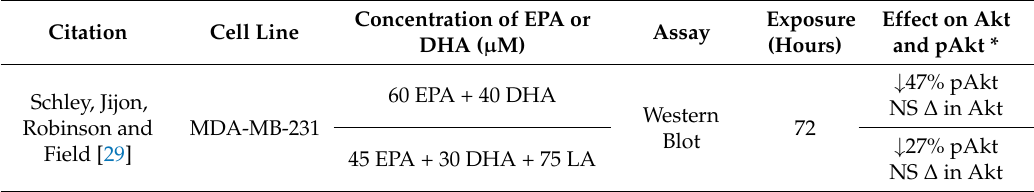
Table 11. Change in Akt and pAkt with EPA:DHA mixtures in human BC cell lines.